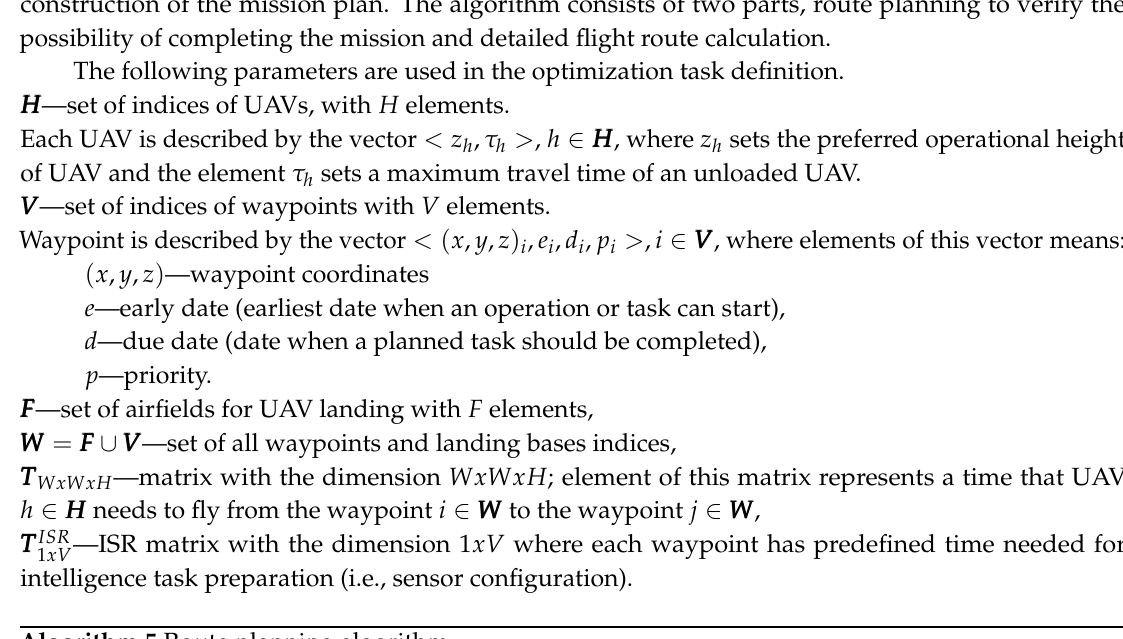
Algorithm 5 Route planning